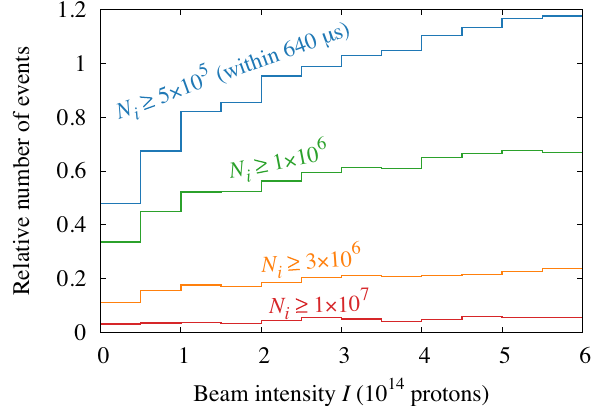
FIG. 13. Simulation predictions of the relative number of dust events exceeding a given number of collisions N i . The absolute number of events was assumed to be independent of the intensity I .